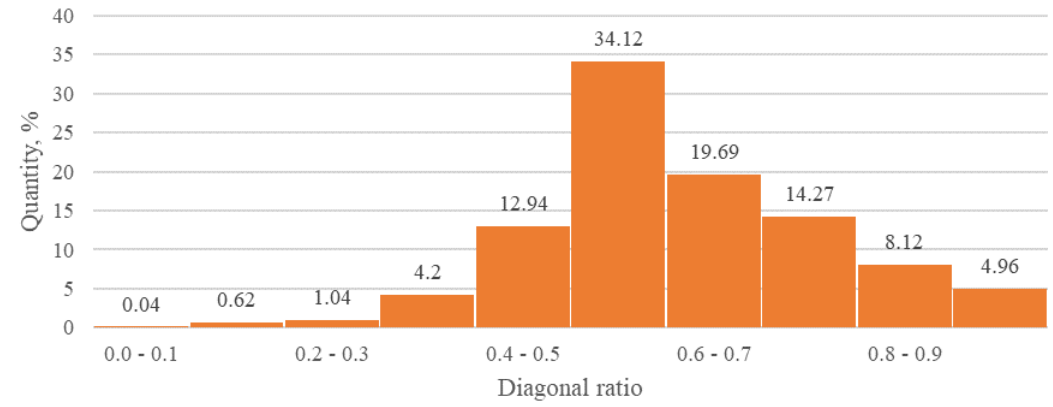
Figure 5. Distribution of monoammonium pellets according to roundness (ratio of diagonals of area limited by pellet’s silhouette).